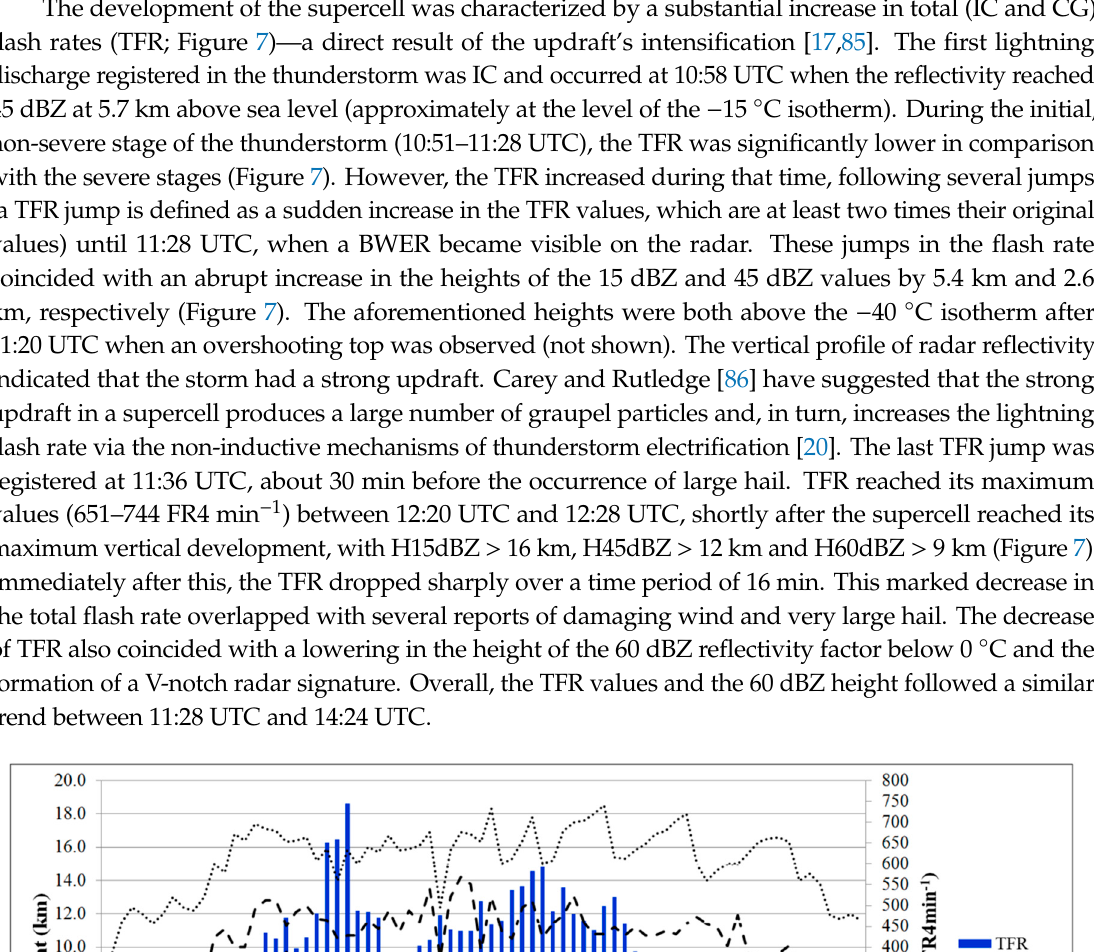
Figure 8. Evolution of the IC-to-CG flash rate (IC_FR/CG_FR) ratio throughout the supercell’s lifecycle.